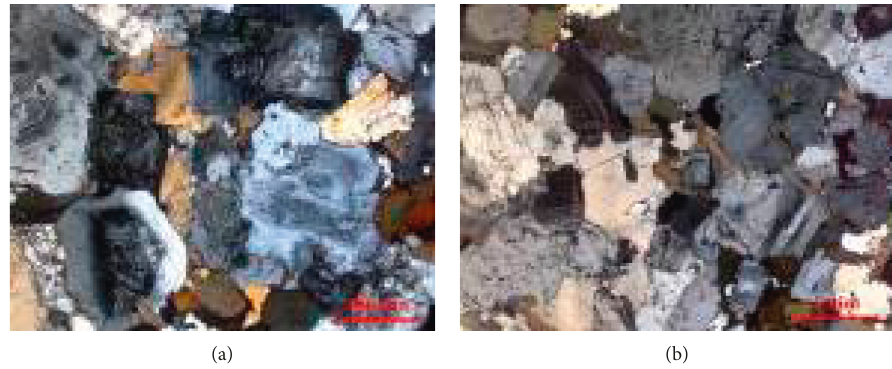
Figure 16: Result of the granite specimen under normal polarizing